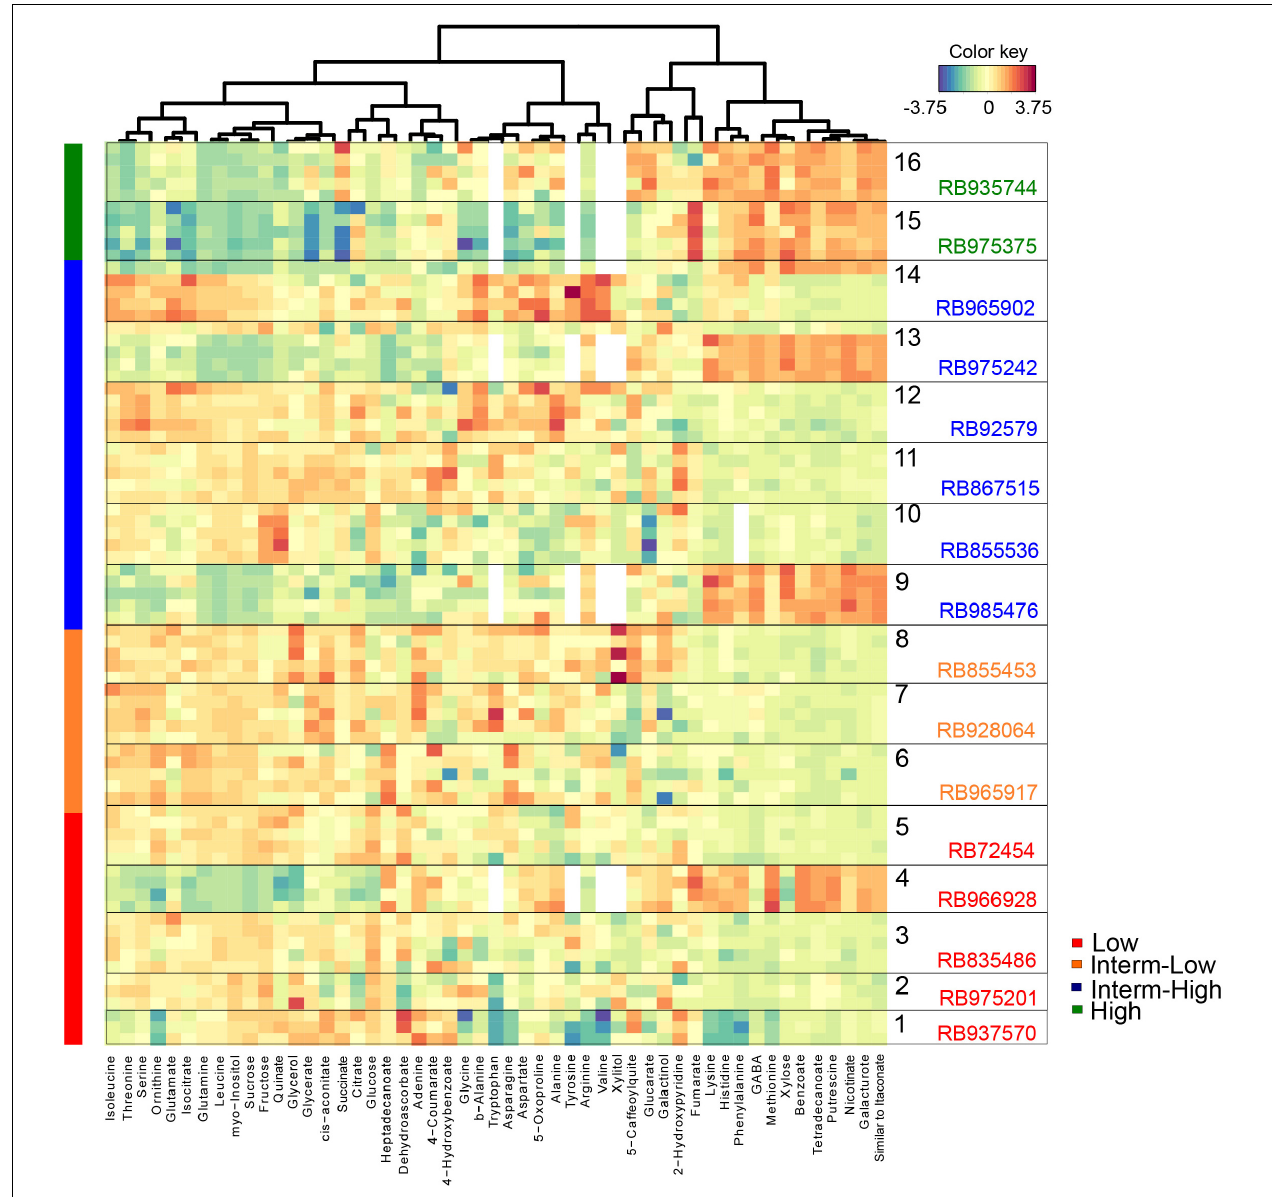
FIGURE 4 | Heat map of metabolites in culms selected by the PLS-DA VIP score. Each row represents a metabolite identified in at least three biological replicates (the number of squares represent the exact number of replicates), whereas columns represent the metabolic abundance among genotypes. Changes in the abundance of metabolites from the overall mean concentration for each genotype are shown in blue (low correlation) or red (high